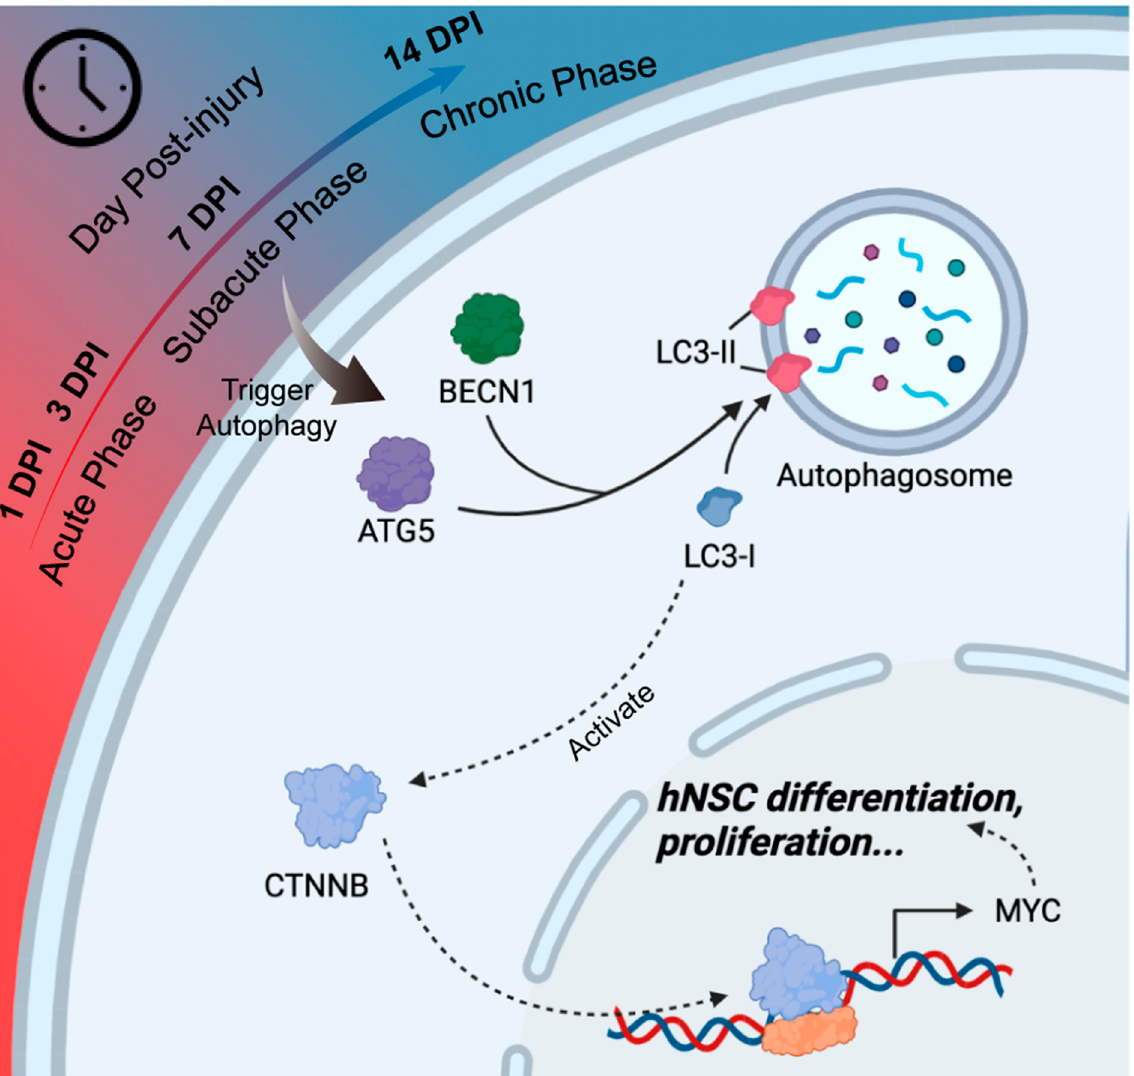
Figure 6. Mechanism diagram of the influence of TBI brain extracts on the neuronal differentiation of hNSCs. TBI brain extracts with different phases differently activated the autophagy flux of hNSCs. In hNSCs, the activation of the autophagy flux correlated with the WNT/CTNNB pathway, which boosted the differentiation and proliferation of hNSCs by regulating the transcription of MYC.